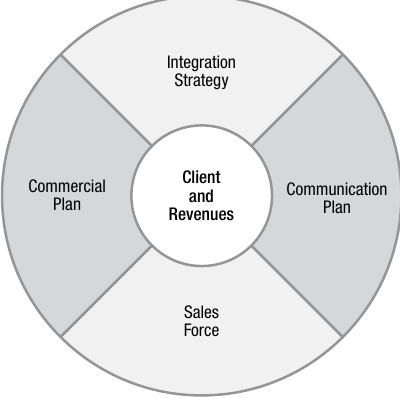
Fig. 1. Drivers of the integration